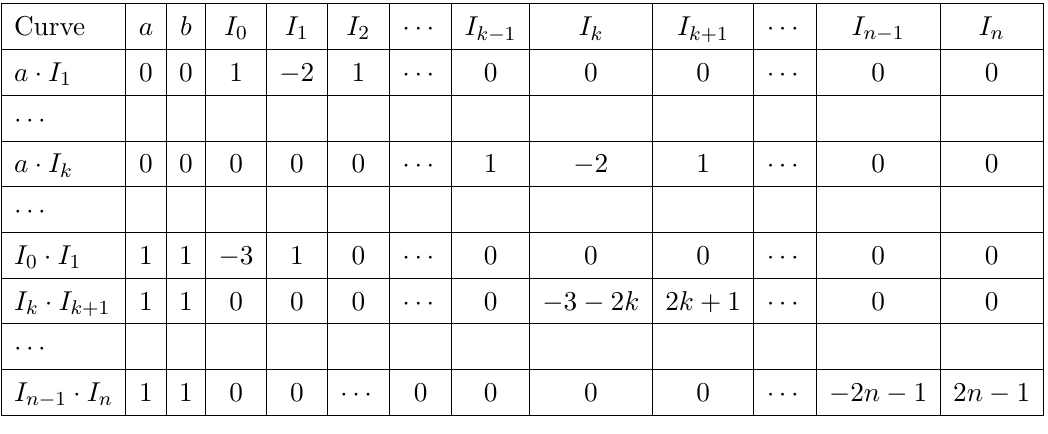
Table 3 . The intersection numbers of the (2 P − 1) compact curves a · I k , I k · I k − 1 and the ( n + 3) points a = ( − 1 , 0) , b = (1 , − 1) and I i = (0 , i ) , where i ∈ { 0 , 1 , 2 , · · · , n } and k ∈{ 0 , 1 , 2 , · · · , ( n − 1) } . We have omitted the result for the curves b · I k and a · I 0 as they give the same intersection numbers as a · I k and I 0 · I 1 for each fixed k ,